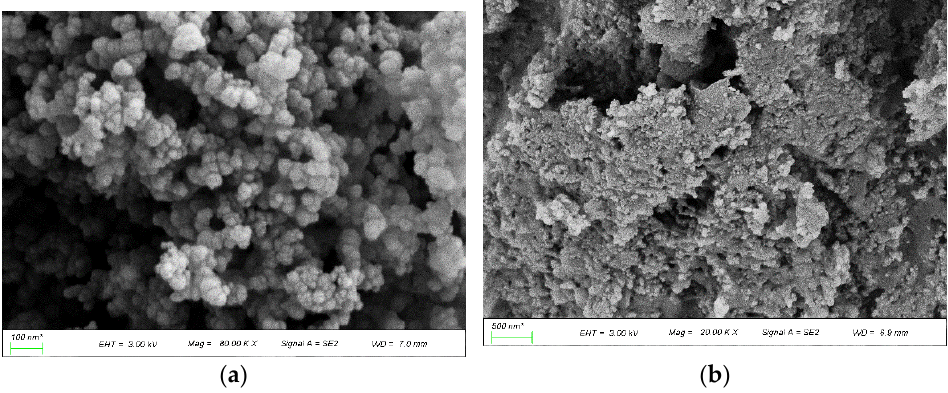
Figure 4. The morphology of the carbon black cluster and the particle dispersion in the resin. ( a ) Carbon black cluster; ( b ) carbon black cluster in the resin.